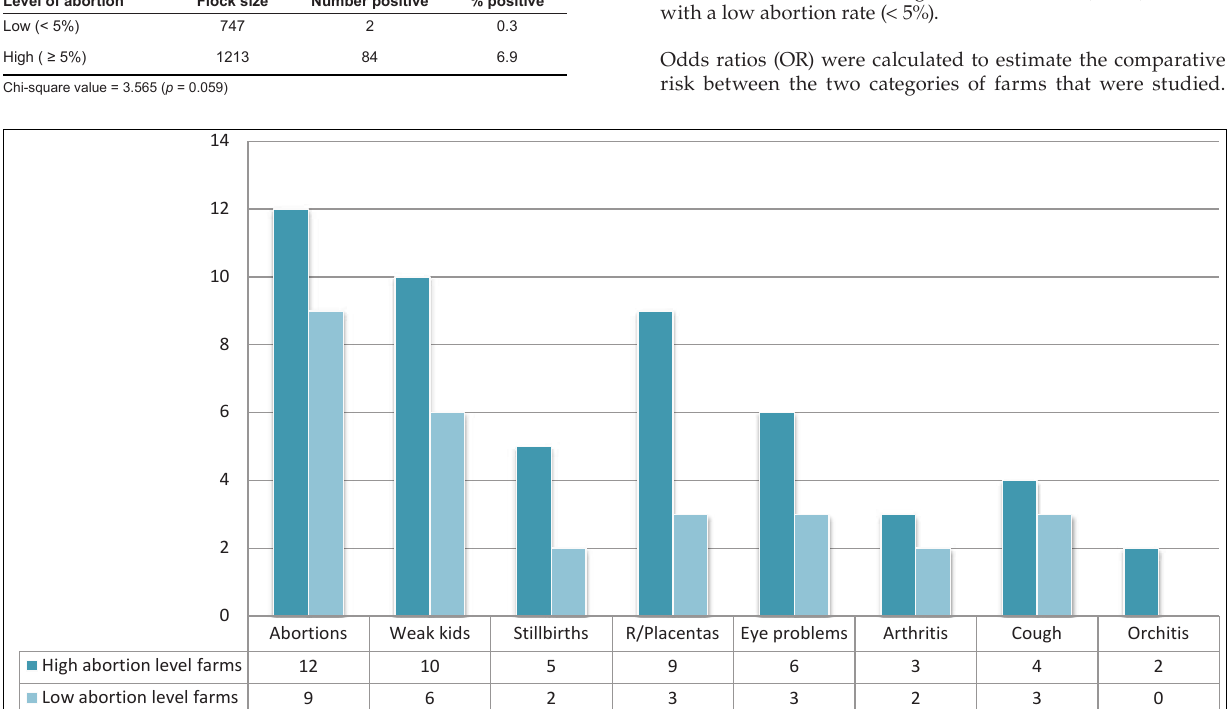
Figure 2 : Histogram showing the scores for various clinical conditions in the two farm categories